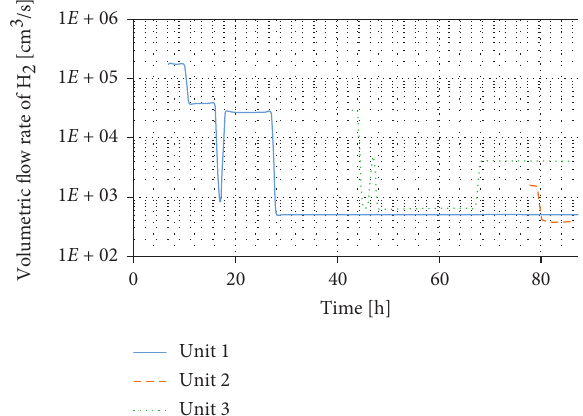
Figure 5: Conditions of the volumetric flow rates of H the RPVs of Units 1–3 for Modified ART Mod 2